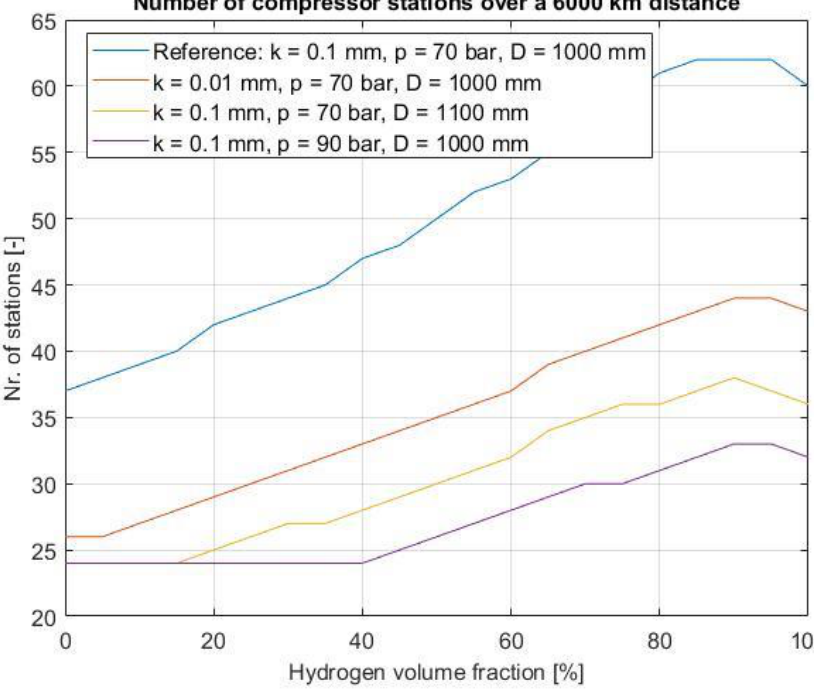
Figure 12. Number of required recompressions.